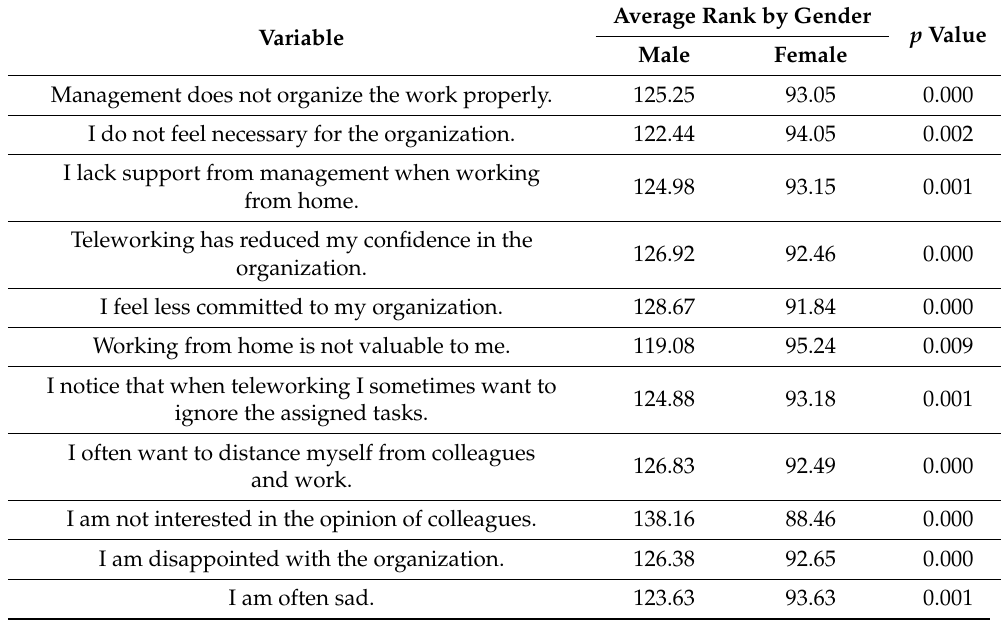
Average Rank by Gender p Value Male Female